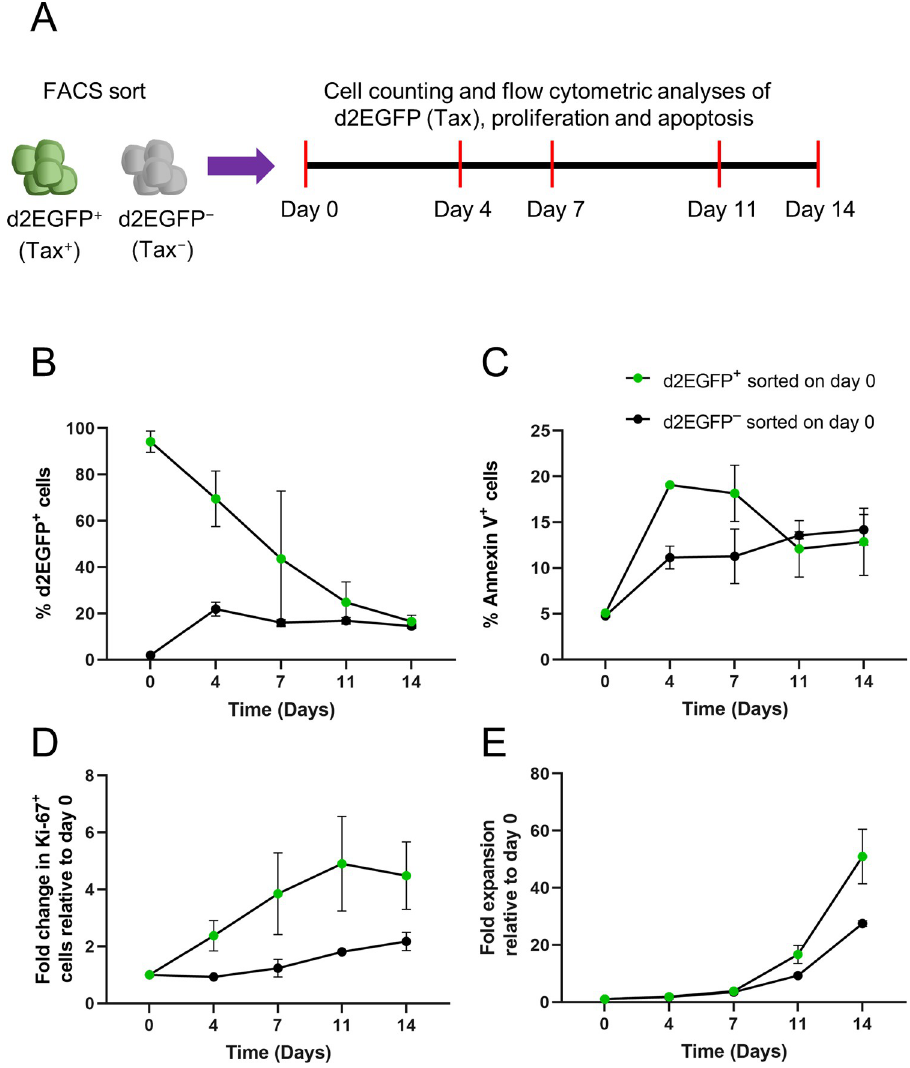
Fig 3. Longer-term consequences of Tax expression on the host cell. (A) Experimental design to determine the longer-term impact of Tax expression. d2EGFP + (Tax + ) and d2EGFP − (Tax − ) cells were FACS sorted and cultured for 14 days. Cell counts and flow cytometric analysis of d2EGFP (Tax) expression, proliferation and apoptosis were performed on days 0, 4, 7, 11 and 14 of the culture. (B) d2EGFP and (C) annexin V expression levels of sorted d2EGFP + and d2EGFP − cells. (D) Fold change in Ki-67 + cells and (E) net expansion of sorted d2EGFP + and d2EGFP − cultures. Data represent the mean ± SEM from two independent experiments using the clone d2EGFP TBW 11.50. The significance of the trend in d2EGFP + and d2EGFP − populations was assessed using the Mann-Kendall